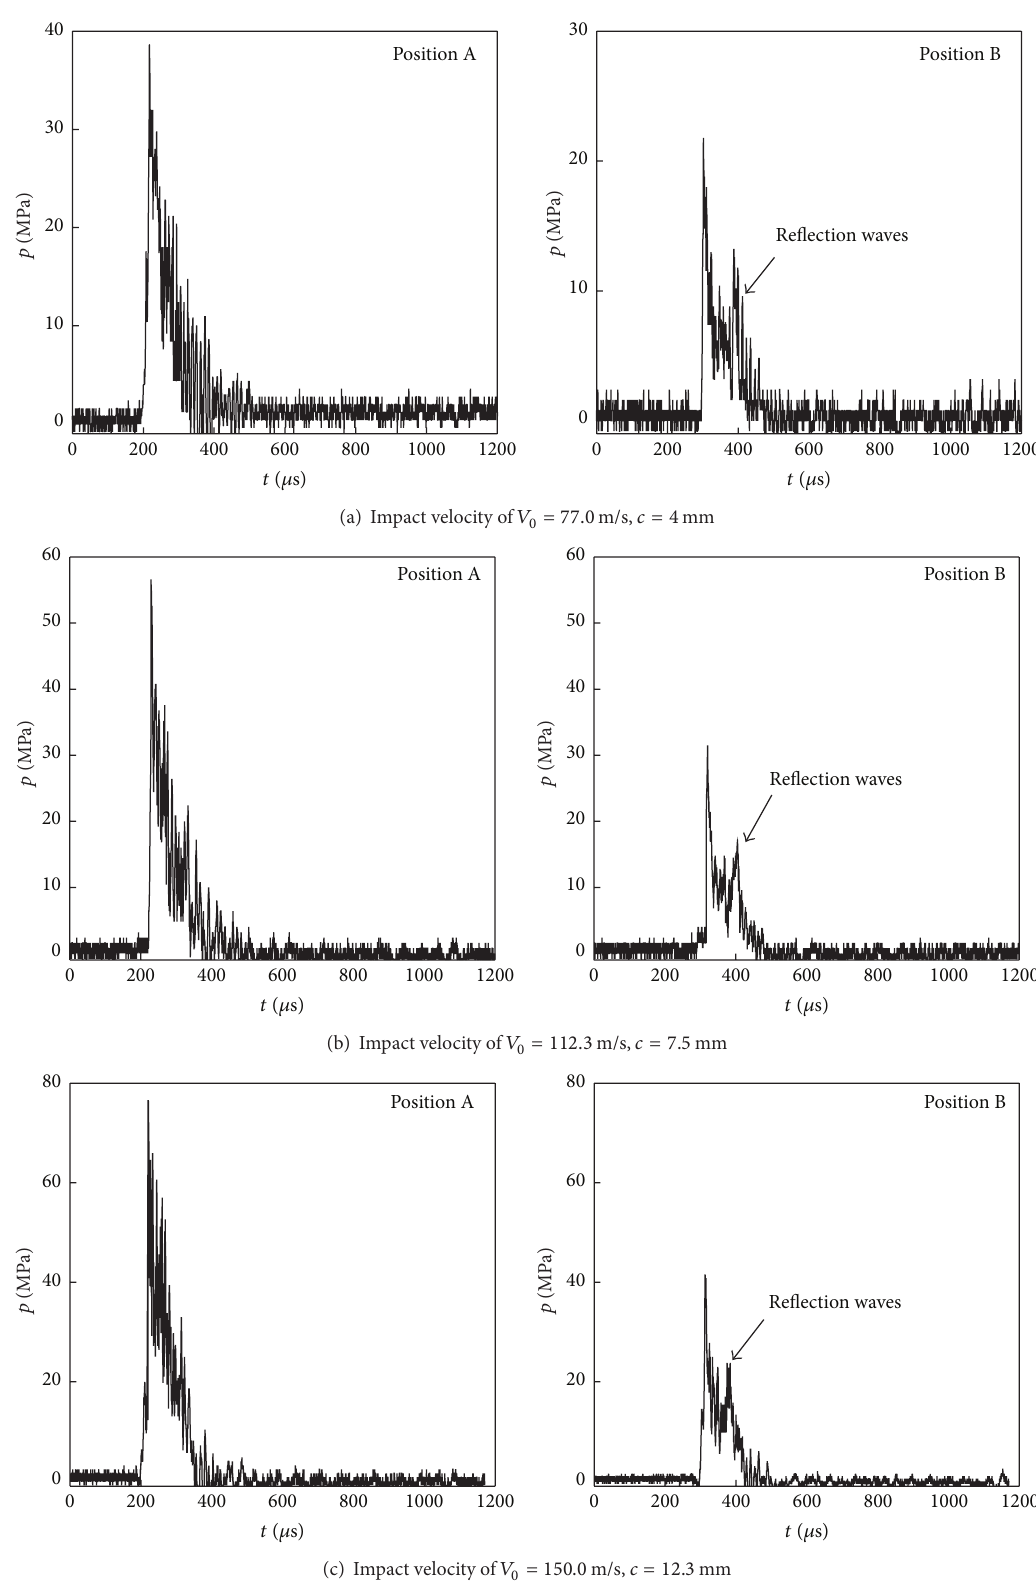
Figure 5: Typical pressure-time history at different load